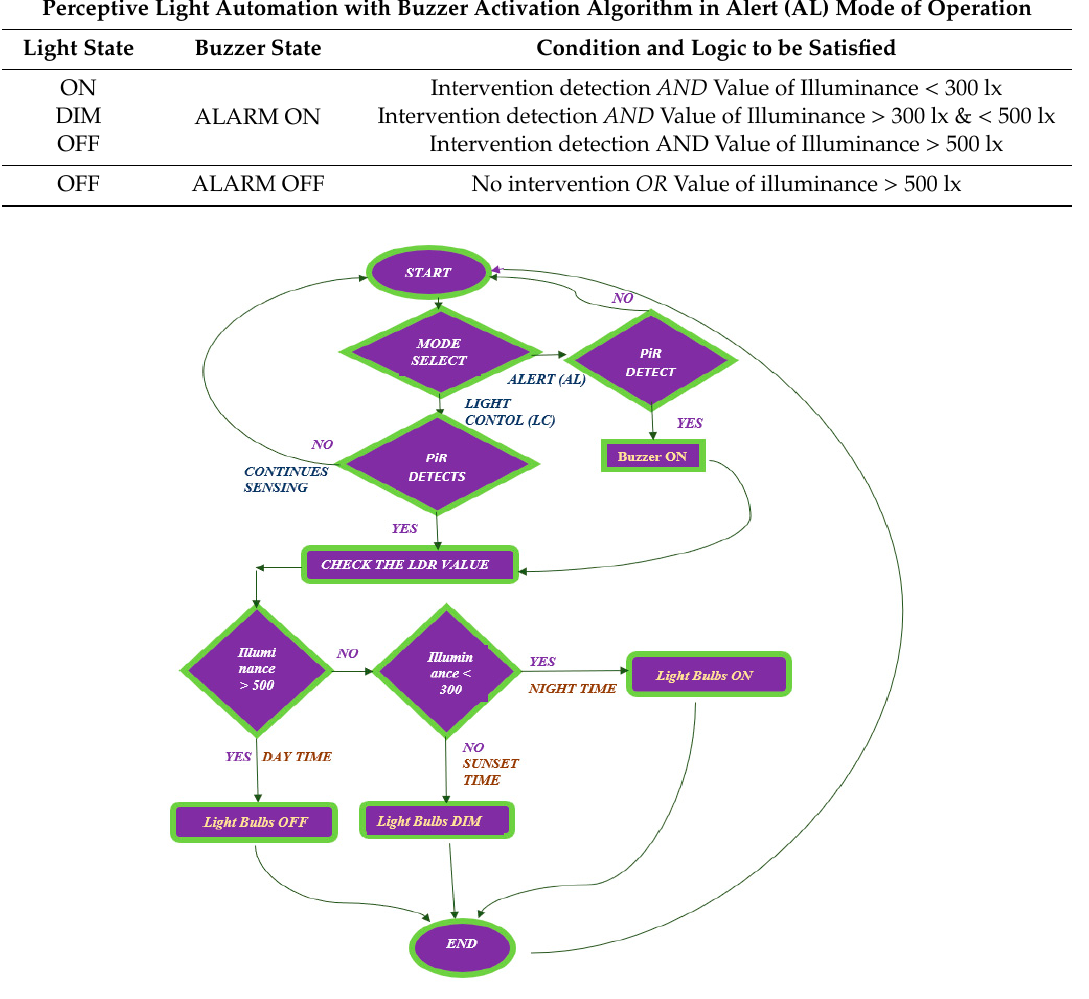
Figure 4. Flowchart of PARSLAD.